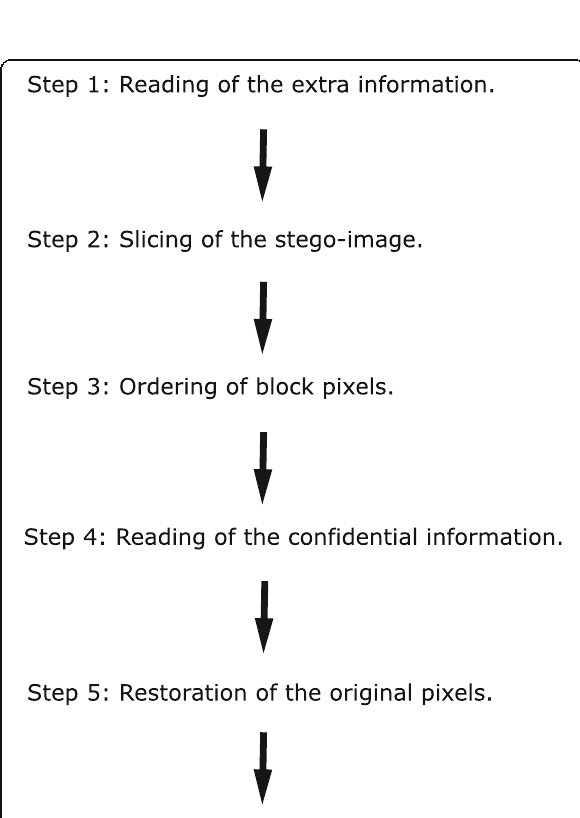
Fig. 3 Ciphertext retrieval steps for the PVO steganography method. (1) Reading of the extra information. (2) Slicing of the stego image. (3) Ordering of block pixels. (4) Reading of the confidential information. (5) Restoration of the original pixels. (6) Restoration of the original pixels